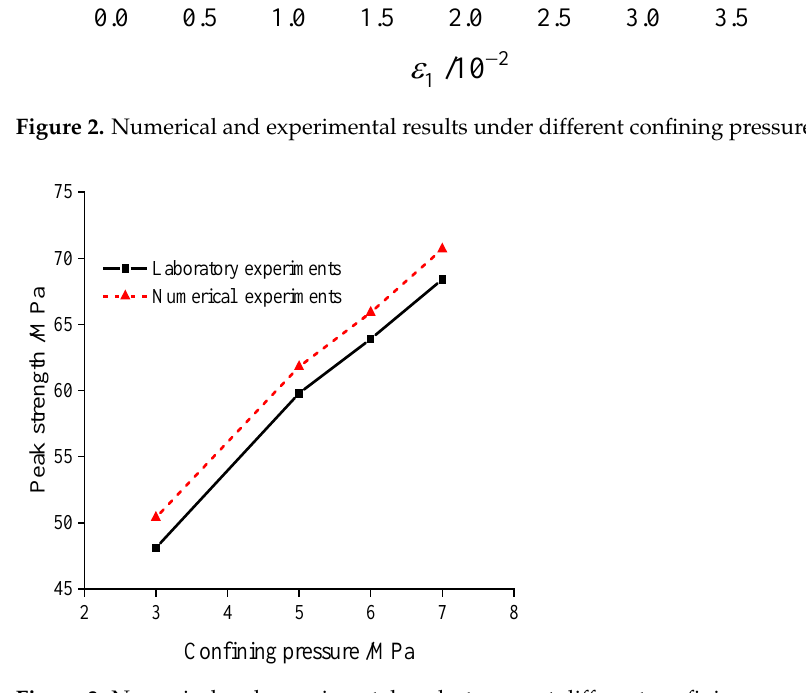
Figure 3. Numerical and experimental peak stresses at different confining pressures. Table 2. Micro-parameters in PFC